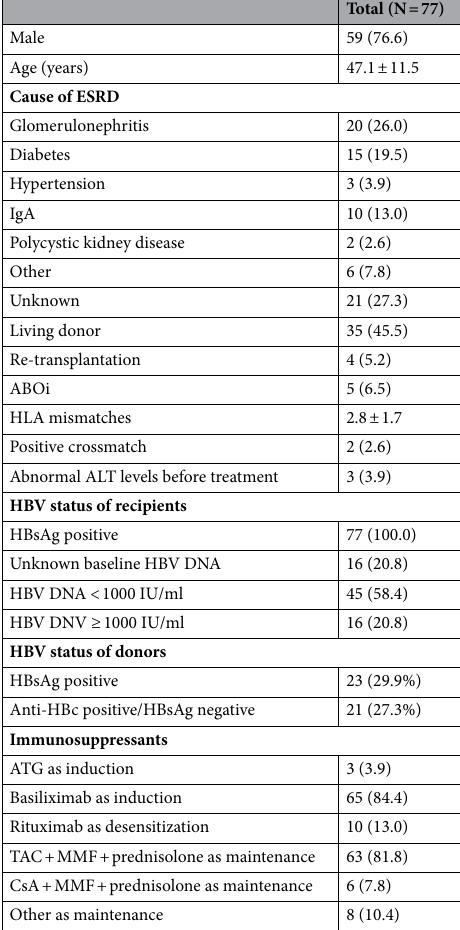
Table 1. Baseline characteristic and immunosuppressants of 77 HBsAg positive kidney transplant recipients. HLA human leukocyte antigen, ATG anti-thymocyte